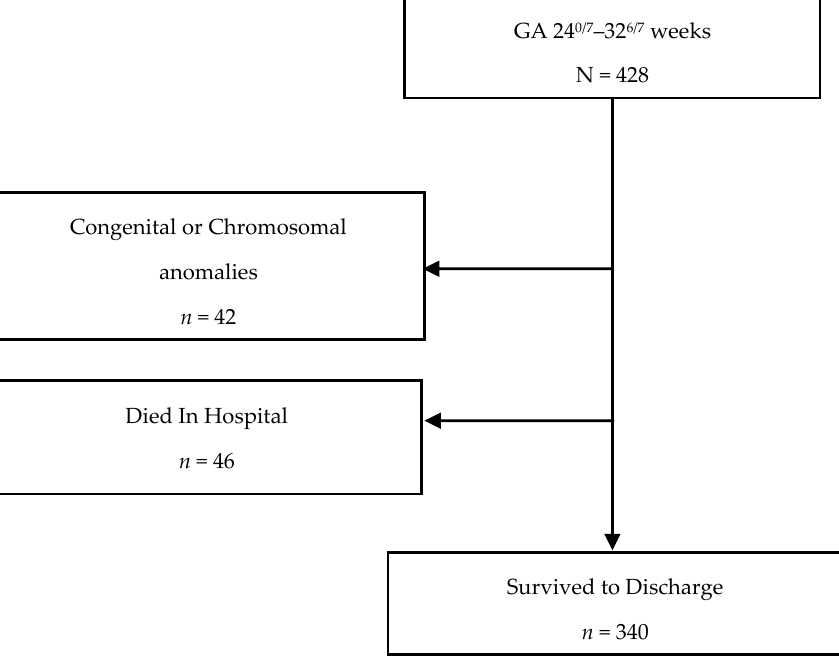
Figure 1. Study population flow chart.